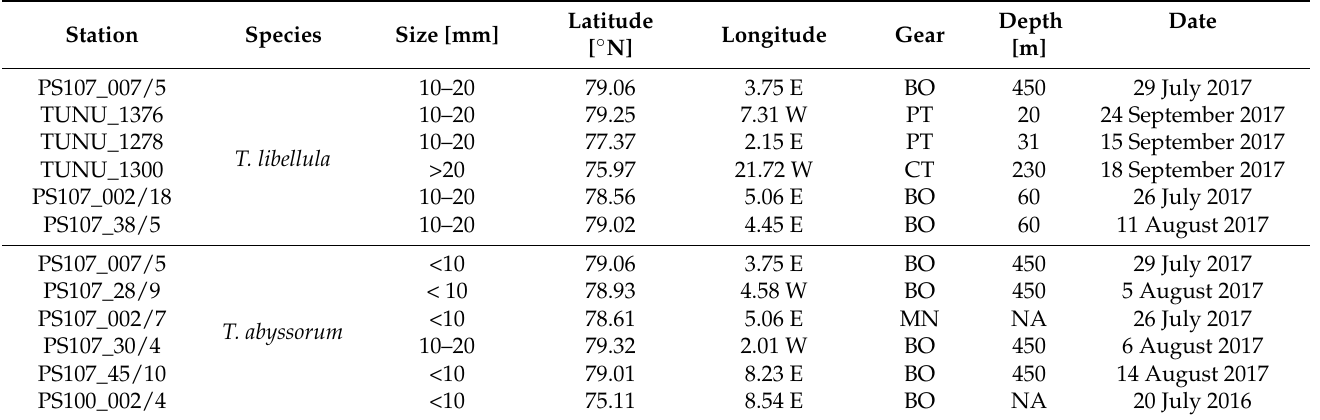
Table 1. Overview of stations and sampling methods during PS100, PS107 and TUNU-VII. BO = Bongo net, PT = Pelagic trawl, CT = Campelan bottom trawl, MN = Multi net. Depth refers to sampling depth at the